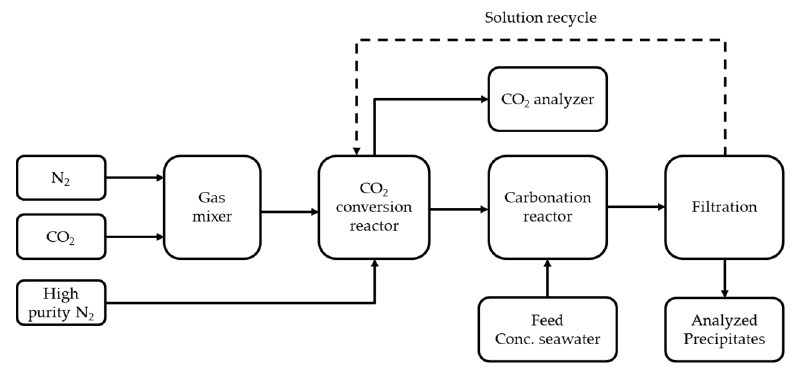
Figure 1. Schematic diagram and apparatus for experiment.